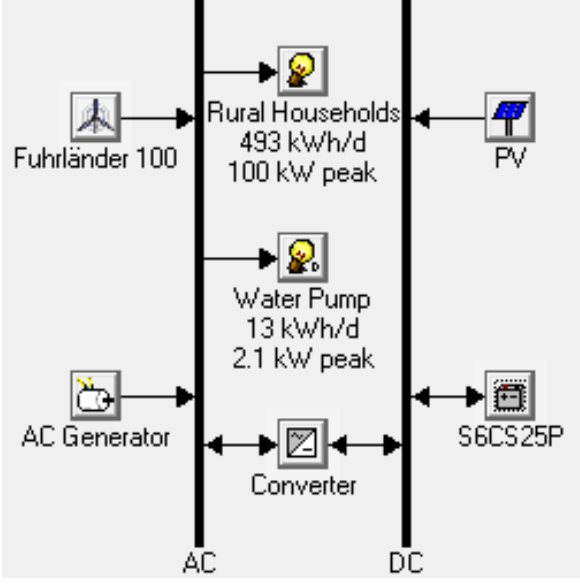
Figure 5: Wind-PV-Diesel Generator Hybrid Model Used in the Study